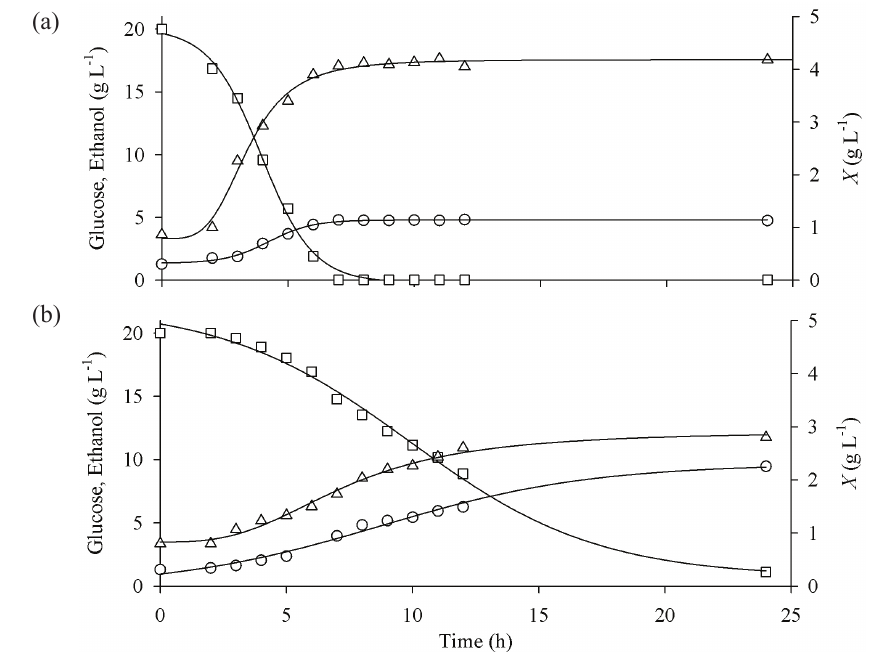
Fig. 3 – Changes in glucose (  ), ethanol (  ), and biomass dry weight (  ) concen- trations during aerobic (a), and anaerobic (b) cultivation of genetically engineered S. cerevisiae on control media containing glucose in shake